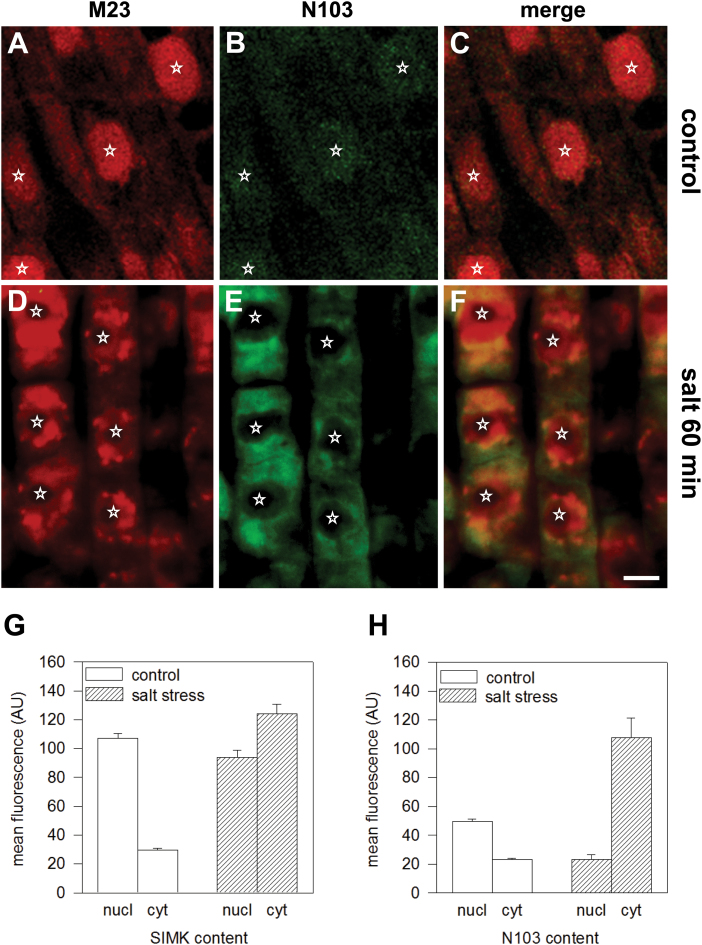
Co-localization of total and active SIMK using double immunolabelling. (A–C) Immunolabelling with protein-specific antibody M23 (A, directly labelled with Alexa Fluor 568, red) and phospho-specific antibody N103 (B, directly labelled with Alexa Fluor 488, green) in control non-dividing elongating epidermal root cells of M. sativa. The merged image is shown in (C). (D–F) Immunolabelling with protein-specific antibody M23 (D, directly labelled with Alexa Fluor 568, red) and phospho-specific antibody N103 (E, directly labelled with Alexa Fluor 488, green) in salt-stressed (250mM NaCl for 60min) non-dividing elongating epidermal root cells of M. sativa. The merged image is shown in (F). Nuclei are indicated with stars. (G, H) Microfluorometric measurements showing the change in nucleocytoplasmic redistribution of the total (G) and activated (H) pool of SIMK in control (open bars) and salt-stressed (hatched bars) M. sativa root cells that were simultaneously co-immunolocalized with both M23 and N103 antibodies. Mean fluorescence is shown in arbitrary units (AU, mean±standard deviation). nucl, Nuclei, cyt, cytoplasm, n=30. Bar, 10 μm (A–F).